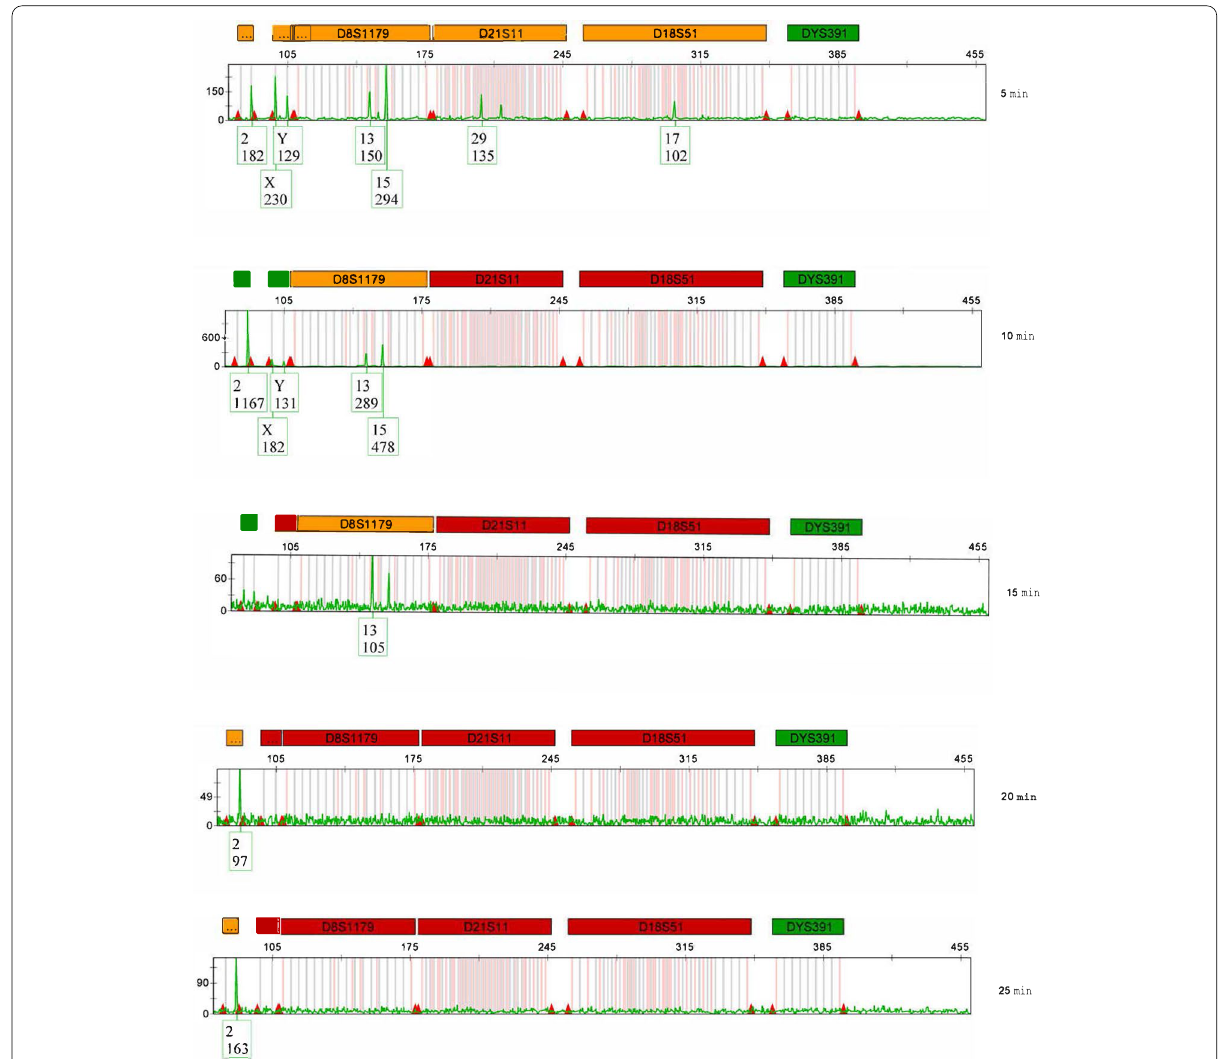
Fig. 2 The effect of UV light in DNA sterilization using different time